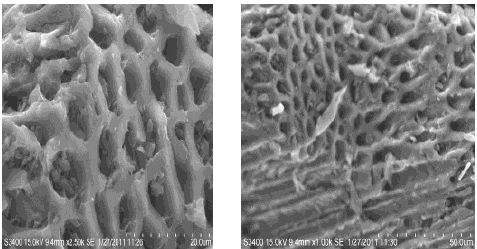
Figure 3. SEM Photograph of ACC (at 2500 X and 1000X).